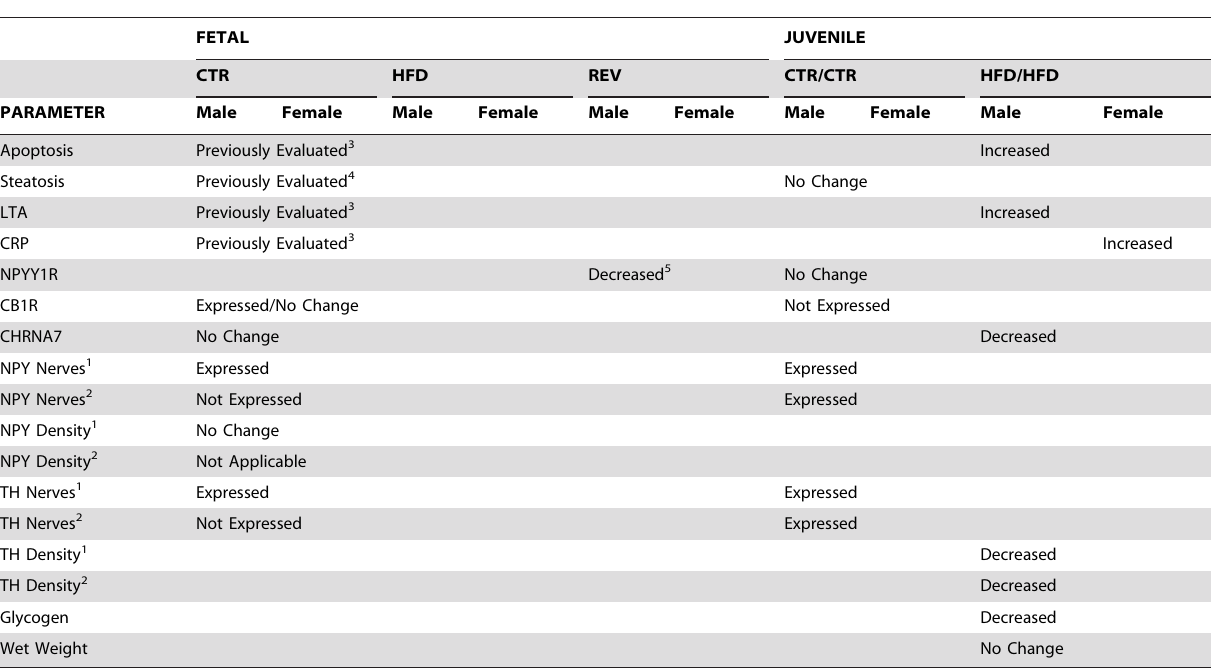
Table 4. Summary of Significant Results in Fetal and Juvenile